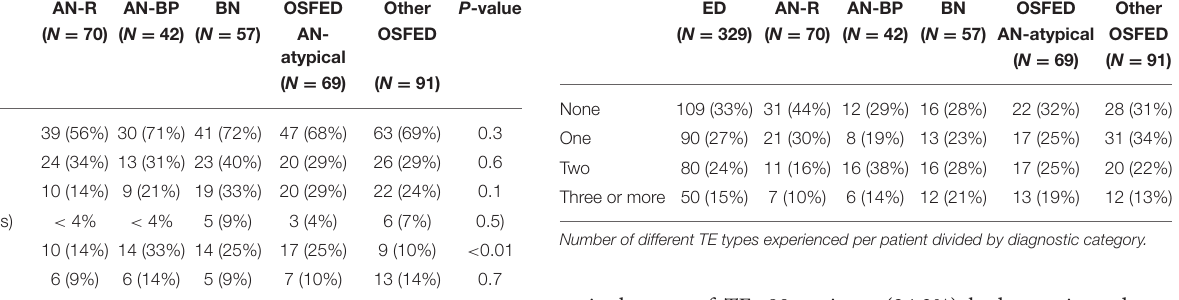
TABLE 3 | Total number of different TE types experienced by each patient in the whole group and per diagnostic category.